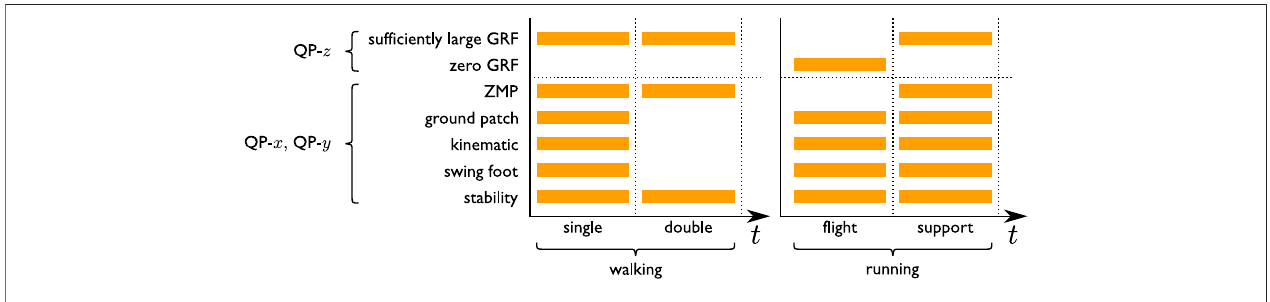
FIGURE 8 | Activation of the various constraints during a i ) walking and ii ) running